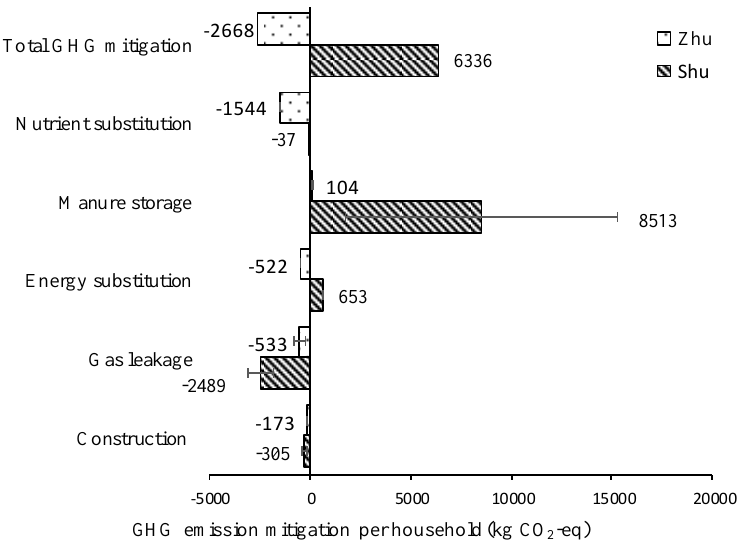
Figure 3. Annual GHG mitigation of household biogas in two villages. Positive (+) and negative ( − ) values represent GHG mitigation and net emission, respectively.